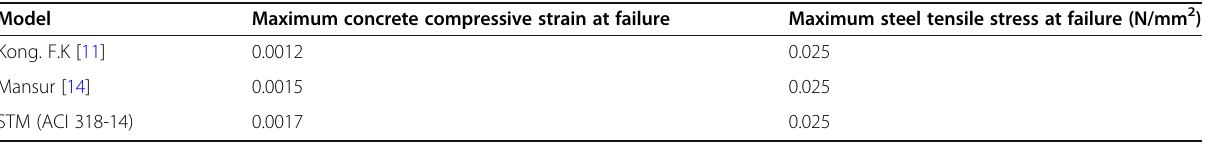
Table 3 Max. concrete compressive strain and max. steel tensile stress at failure for the different models Model Maximum concrete compressive strain at